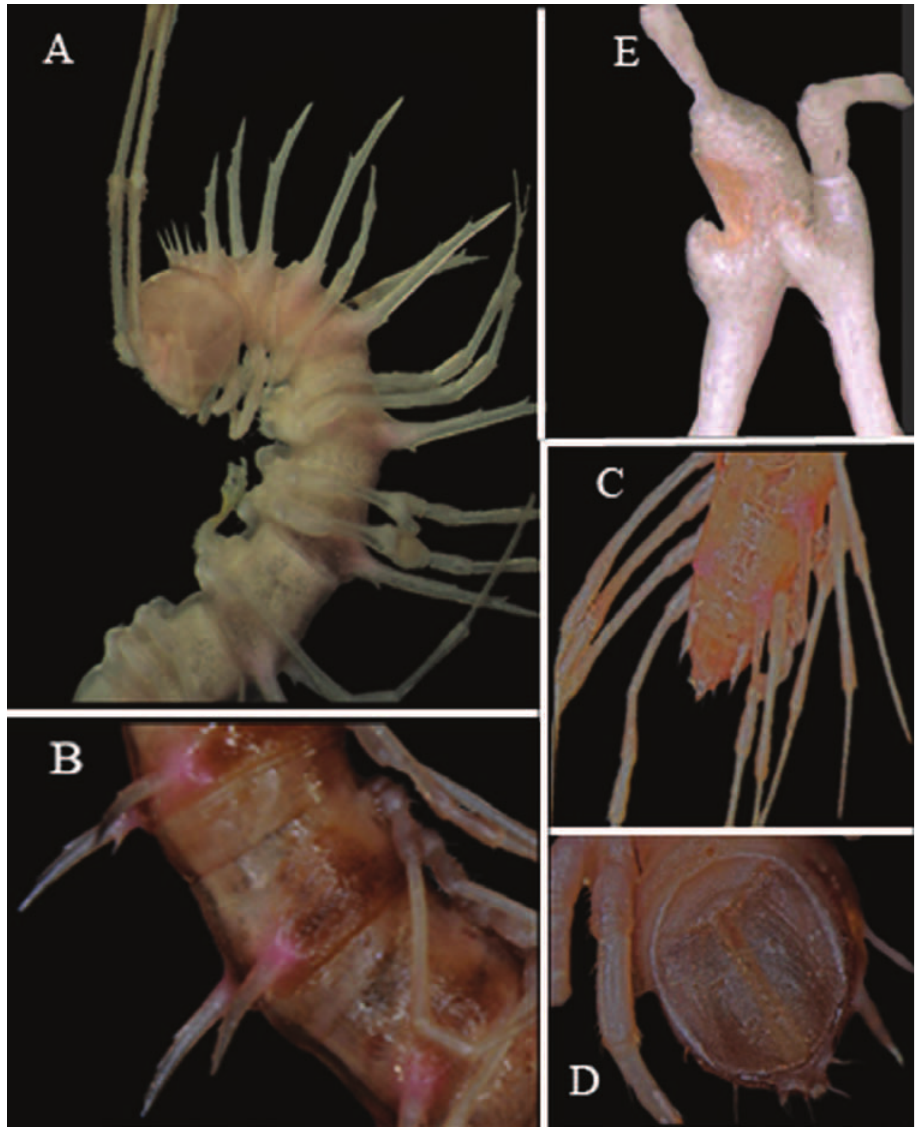
Figure 3. Desmoxytes spinissima sp. n., ♂ holotype. A anterior part of body, lateral view B midbody seg- ments, lateral view C posterior part of body, dorsal view D telson, ventral view e femora 6 and 7, lateral view. Photographed not to